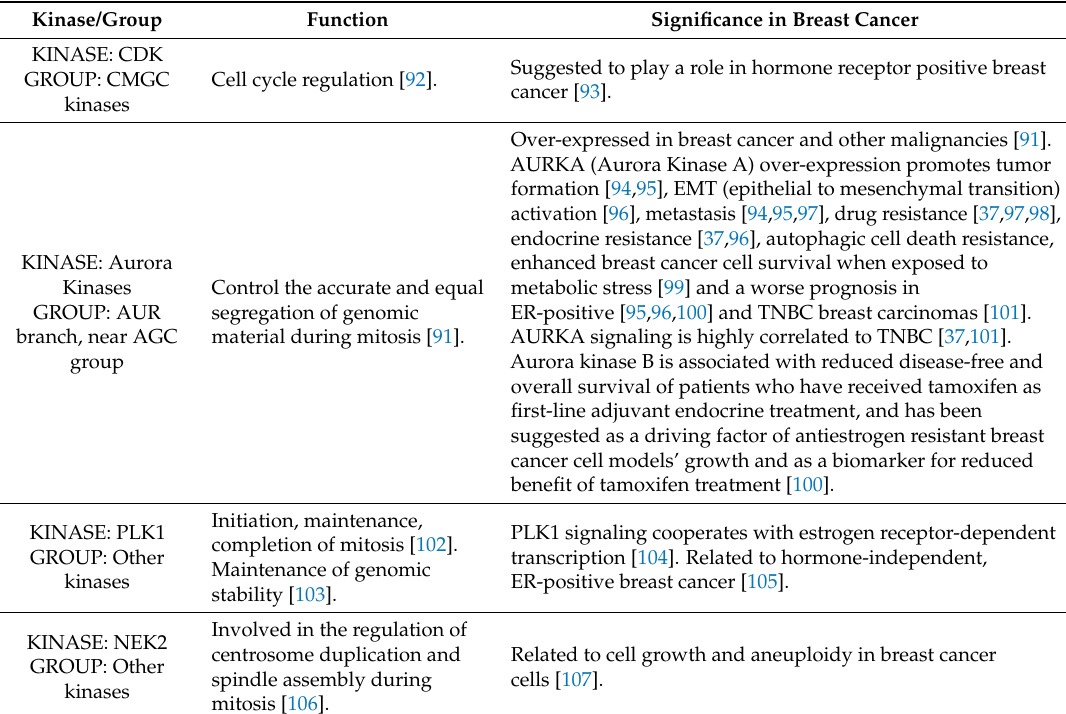
Table 8. Cell cycle proteins alterations and significance in breast